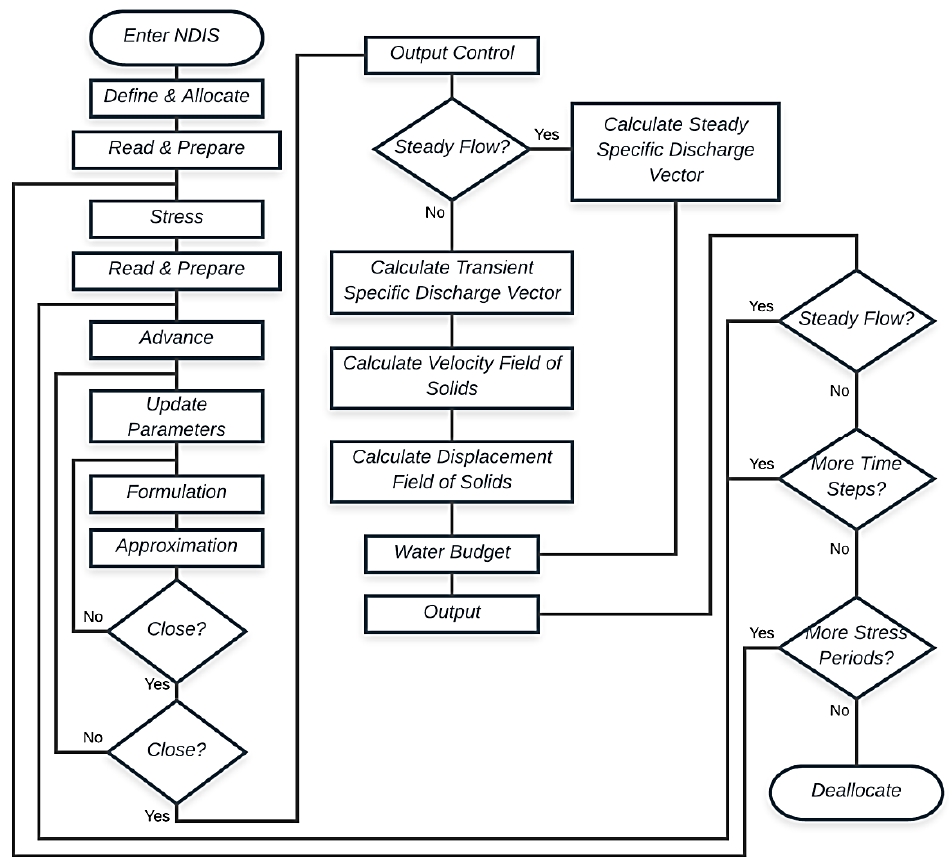
Figure 3. NDIS Flowchart to simulate movement of an aquifer system with sedimentary material having nonlinear stress-strain behavior.